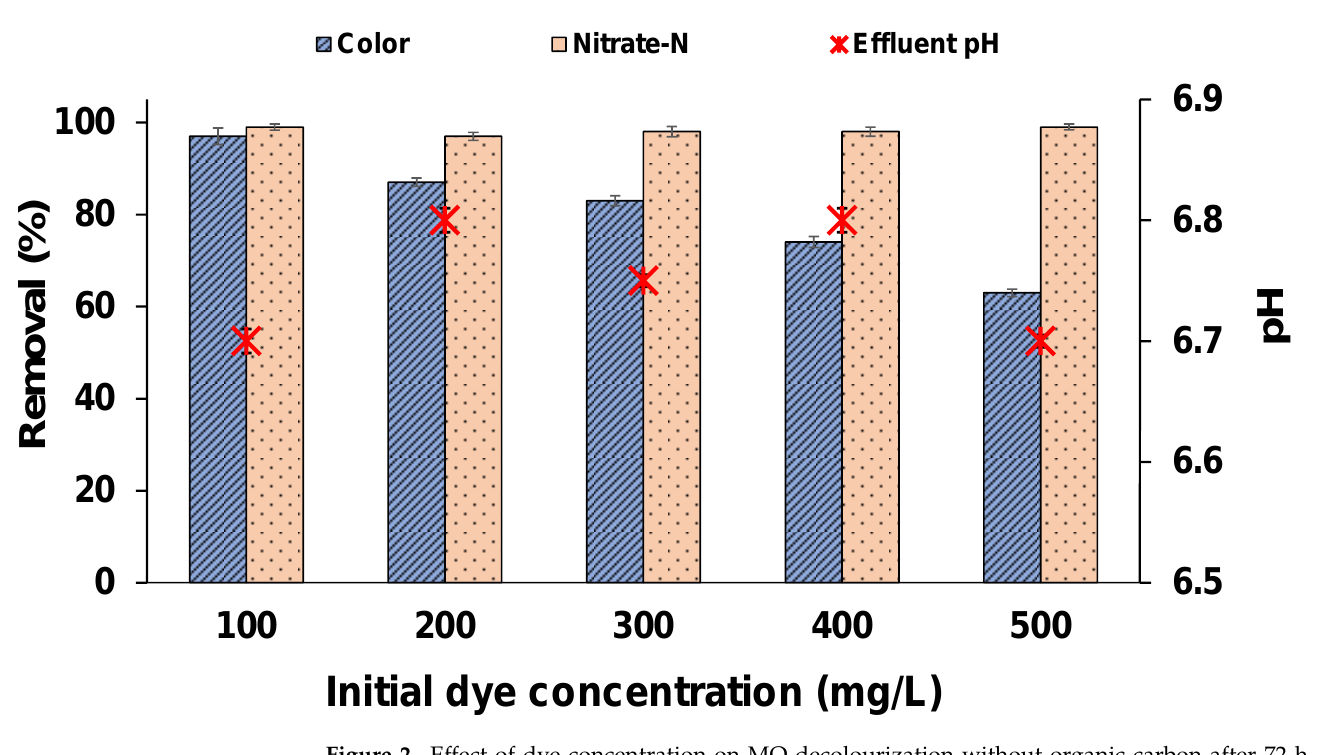
Figure 2. Effect of dye concentration on MO decolourization without organic carbon after 72 h (temperature: 30 ± 2 °C; volume: 150 mL; MLSS: 1 g/L; RPM: 110 ± 2; time: 72 h).